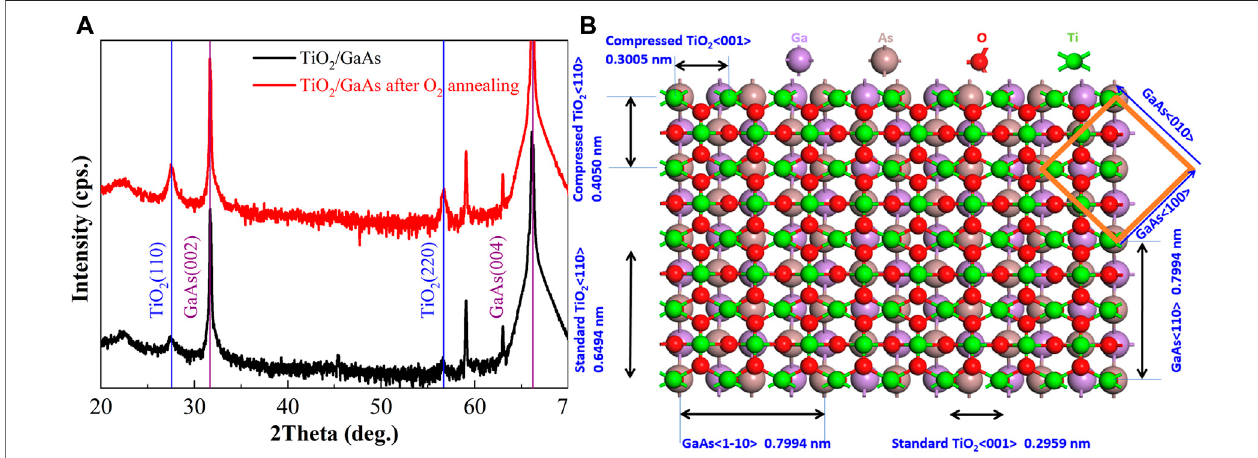
FIGURE2|(A) XRD2 θ scansoftheTiO 2 /GaAsheterostructurewithandwithout in-situ annealinginO 2 ; (B) In-planeepitaxialrelationshipbetweenGaAs(001)and TiO 2 (110) with compressive